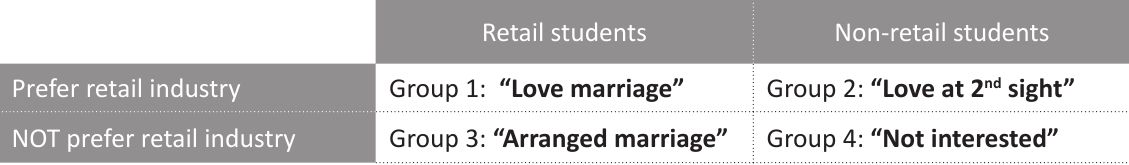
Figure 1. Student-retail